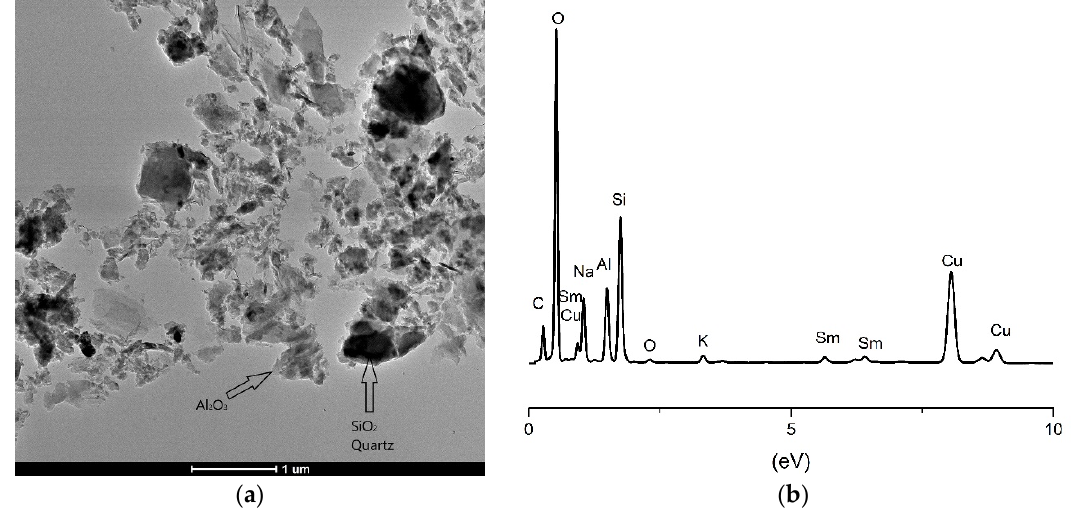
Figure 8. TEM analysis of geopolymer: ( a ) with 5% Sm; ( b ) corresponding EDS analysis .